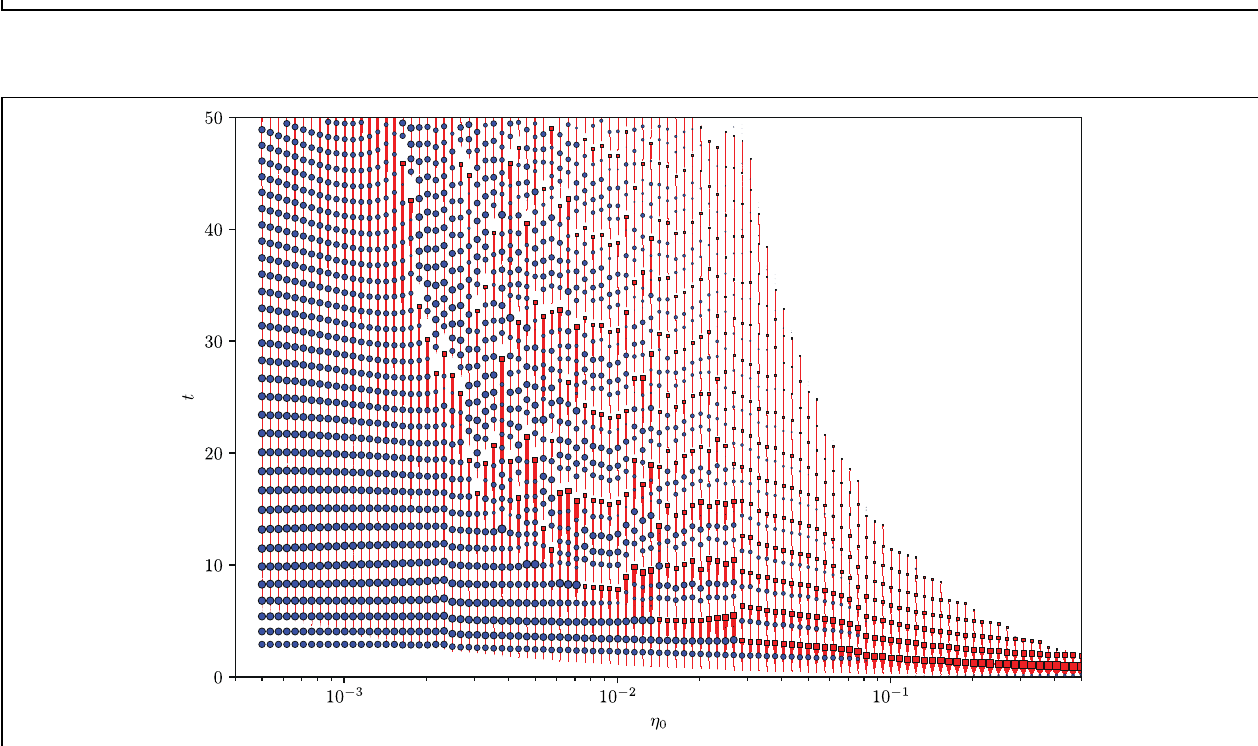
FIGURE 7 | Overview of 100 flux rope simulations, for ν 0 = 0.5 and varying η 0 . Each simulation (for a given η 0 ) is represented by a vertical red line, and the thickness of this line is proportional to the poloidal flux in the rope at that time. Arcade eruptions are represented by blue circles and flux rope eruptions are represented by red squares. The size of these points is proportional to the decrease in open flux and poloidal rope flux during the eruption, respectively.